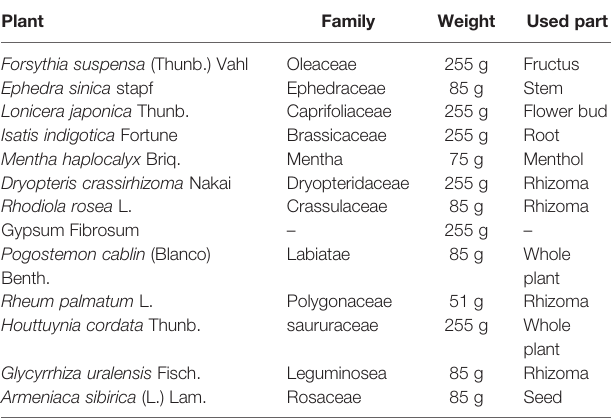
TABLE 4 | Composition of